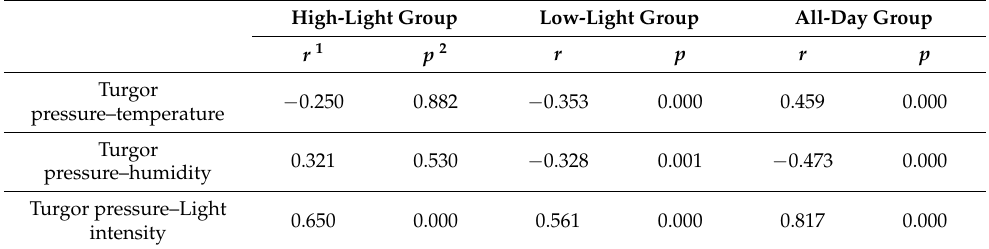
Table 2. Correlation between leaf turgor pressure and environmental factors.